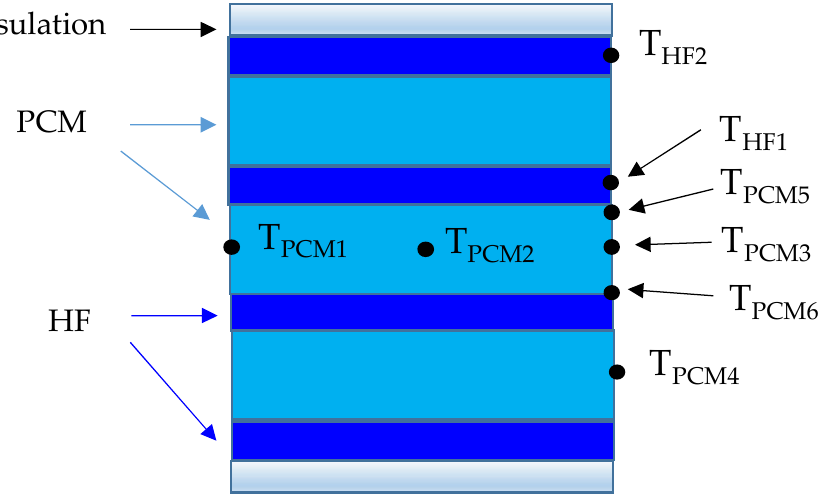
Figure 1. Schematic diagram of the LHST.